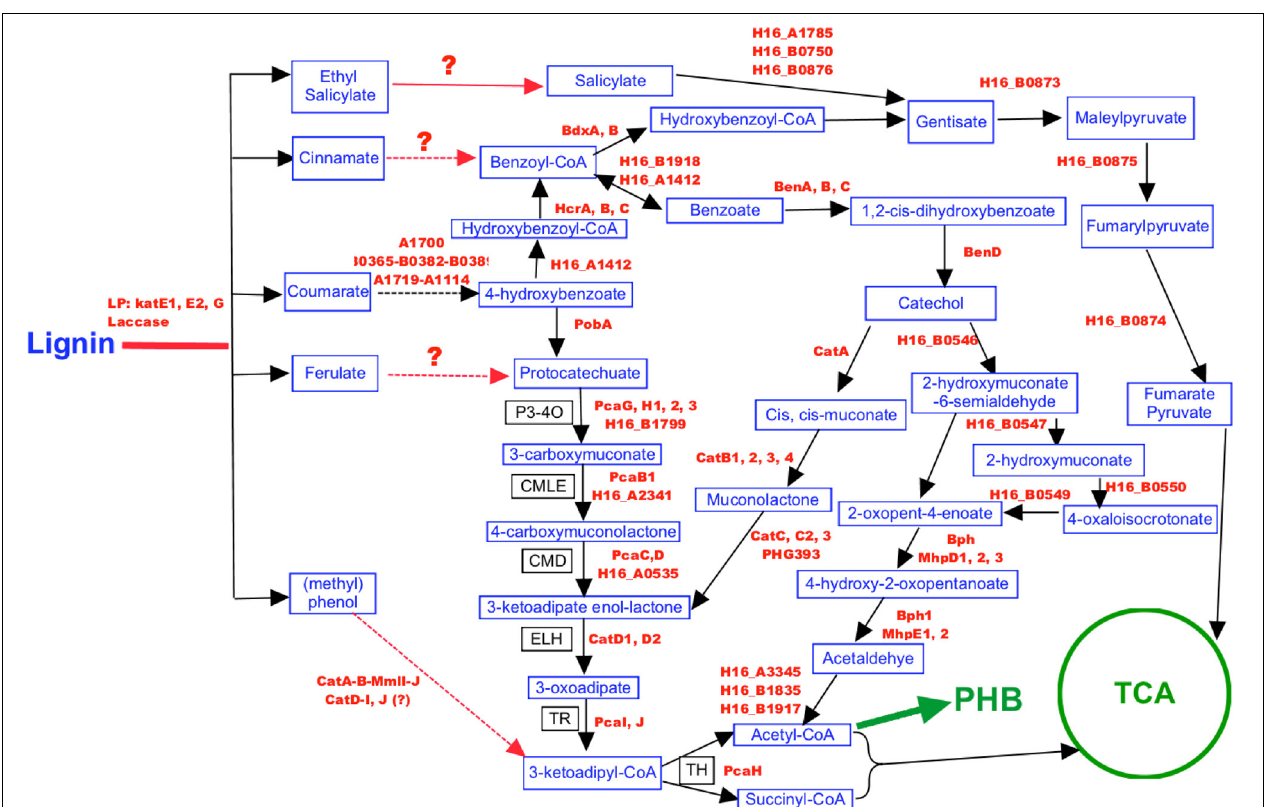
FIGURE 5 | Proposed lignin degradation pathway in C. necator H16. Pathways and reactions with black solid lines have complete genes/enzymes identified in C. necator H16, while the red lines indicate those not completely identified. Genes encoding enzymes for metabolic reactions are bold red